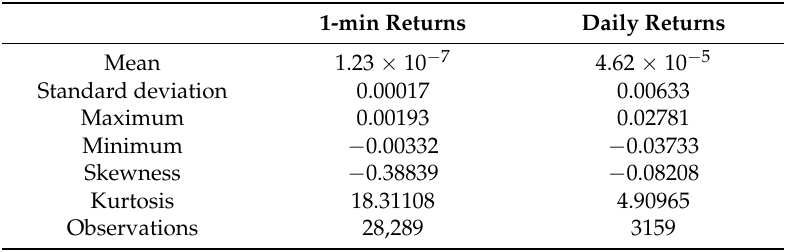
Table A1. EUR/USD Returns descriptive statistics.